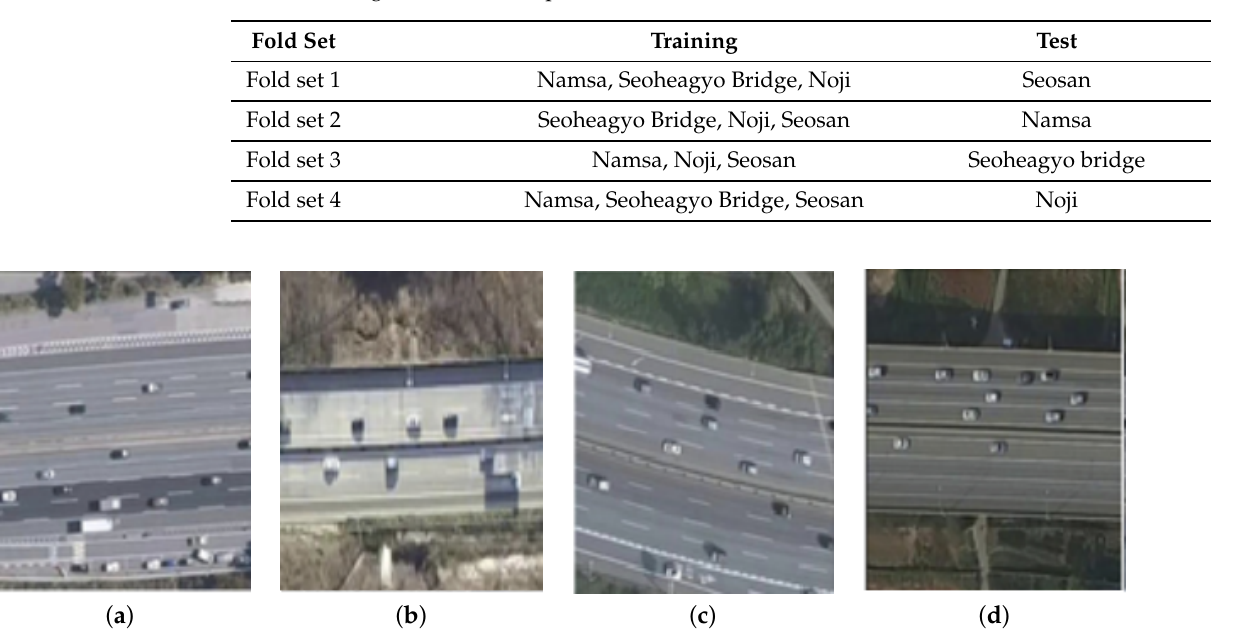
Figure 7. Configuration of experimental data set. ( a ) Namsa; ( b ) Seosan; ( c ) Noji; ( d ) Seoheagyo